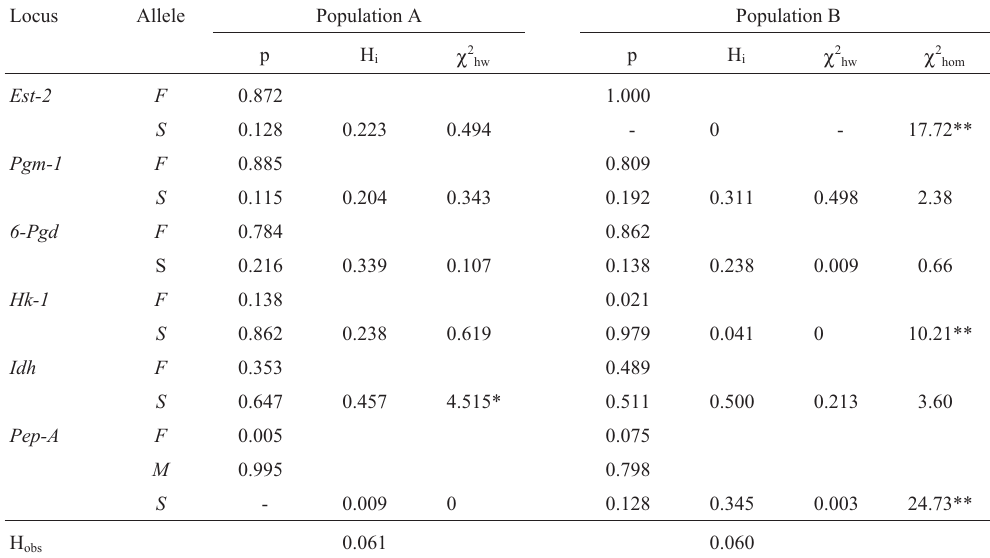
Table 2 - Allele frequencies (p); intra-locus heterozygosity (H and mean observed heterozygosity (H obs ) over 24 enzyme loci in two Polistes satan